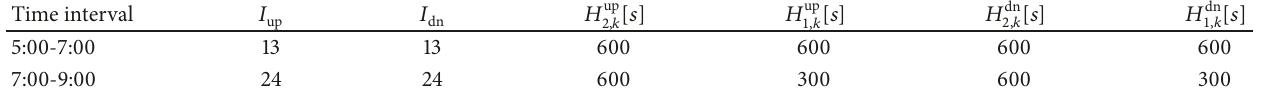
Table 5: Input parameters for case